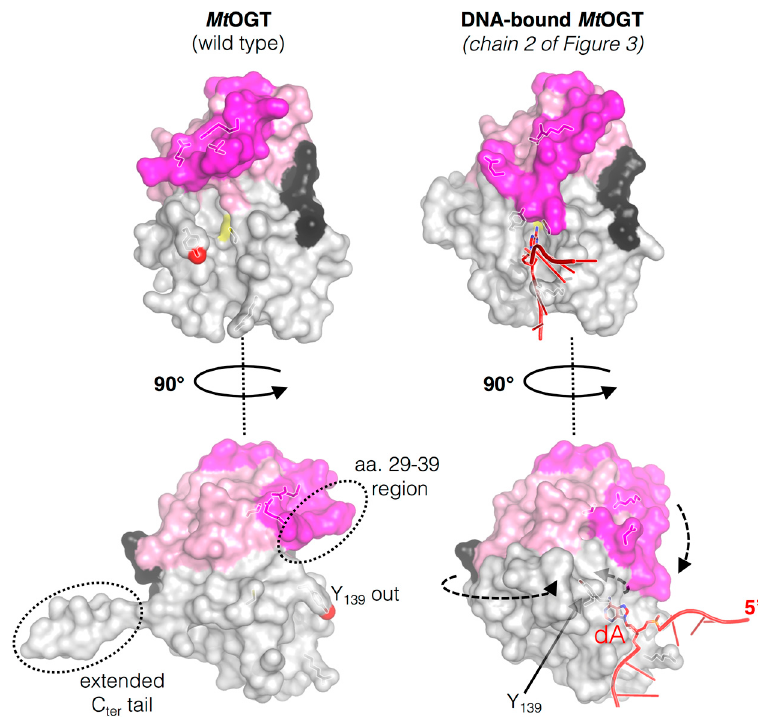
Figure 2. Structural rearrangements occurring on M. tuberculosis OGT ( Mt OGT) in its ligand-free form (Protein Data Base, PDB ID: 4BHB) along DNA binding process (PDB ID: 4WX9); the regions affected by the conformational changes are indicated with dotted circle in ligand-free structure while the arrows indicate the direction of the movements of the N-terminal flap, the active site loop and the C-terminal tail of the protein as consequence of DNA binding (adapted from [45]).